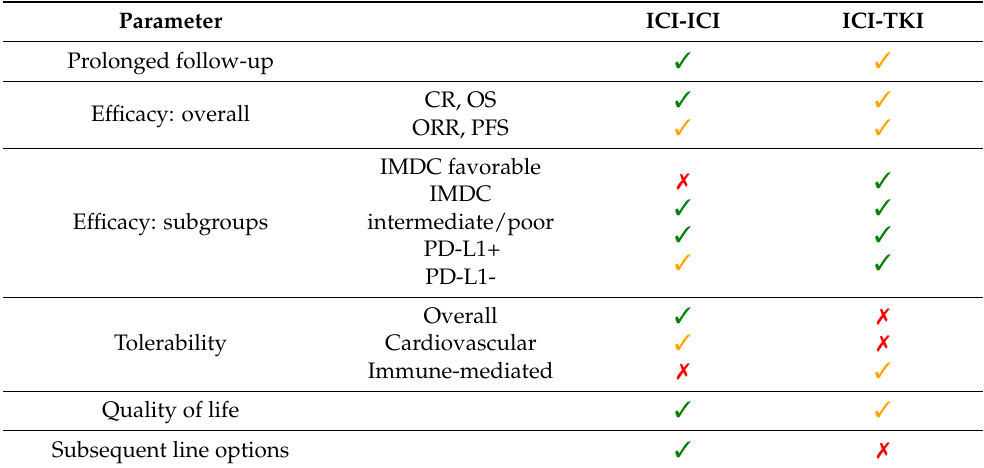
Table 2. Parameters guiding the choice of strategy between ICI/ICI and ICI/TKI combinations. Parameter ICI-ICI